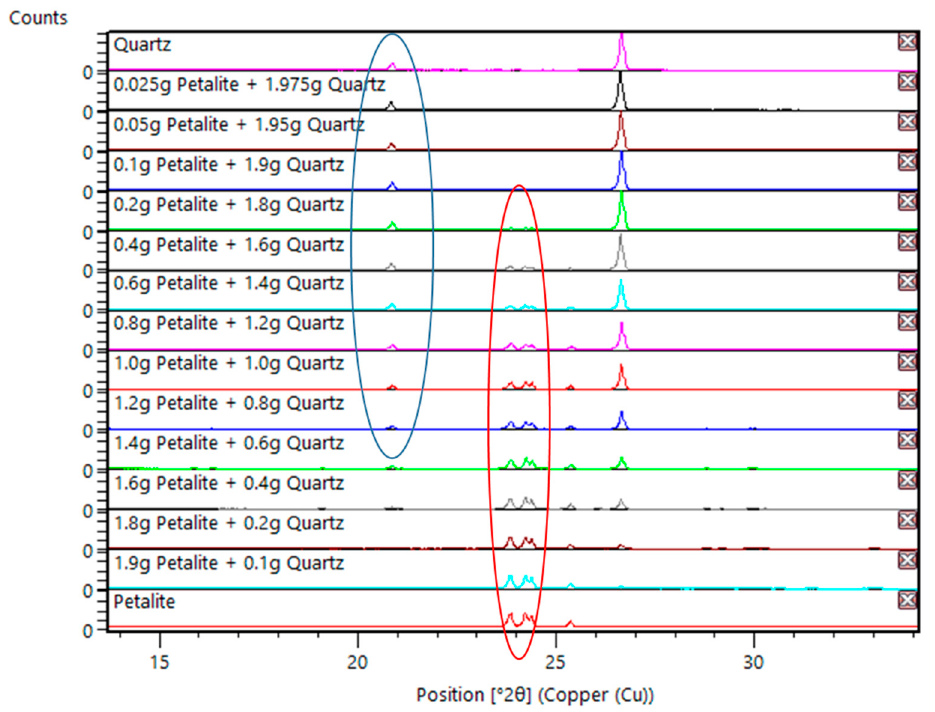
Figure 3. XRD patterns used for the calibration of petalite–quartz weight% mixtures (triplet of petalite peaks and main peak of quartz highlighted).